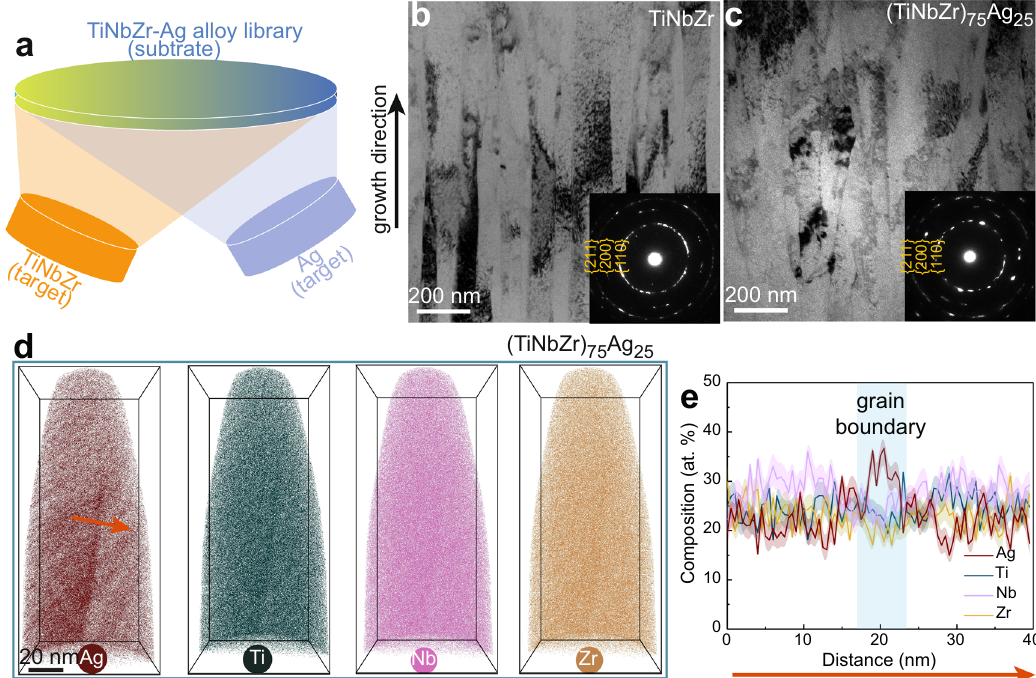
Fig. 1 Fabrication and characterization of the TiNbZr-Ag alloys. a A schematic illustration of the combinatorial magnetron co-sputtering approach. b , c Side-view TEM images of the TiNbZr and (TiNbZr) 75 Ag 25 alloys. The inset images show the corresponding SAED pattern. d Three-dimensional (3D) APT reconstruction showing elemental distribution in the (TiNbZr) 75 Ag 25 alloy. e 1D compositional pro fi le measured along the red arrow in ( d ), showing that the grain boundaries of the (TiNbZr) 75 Ag 25 alloy are enriched with